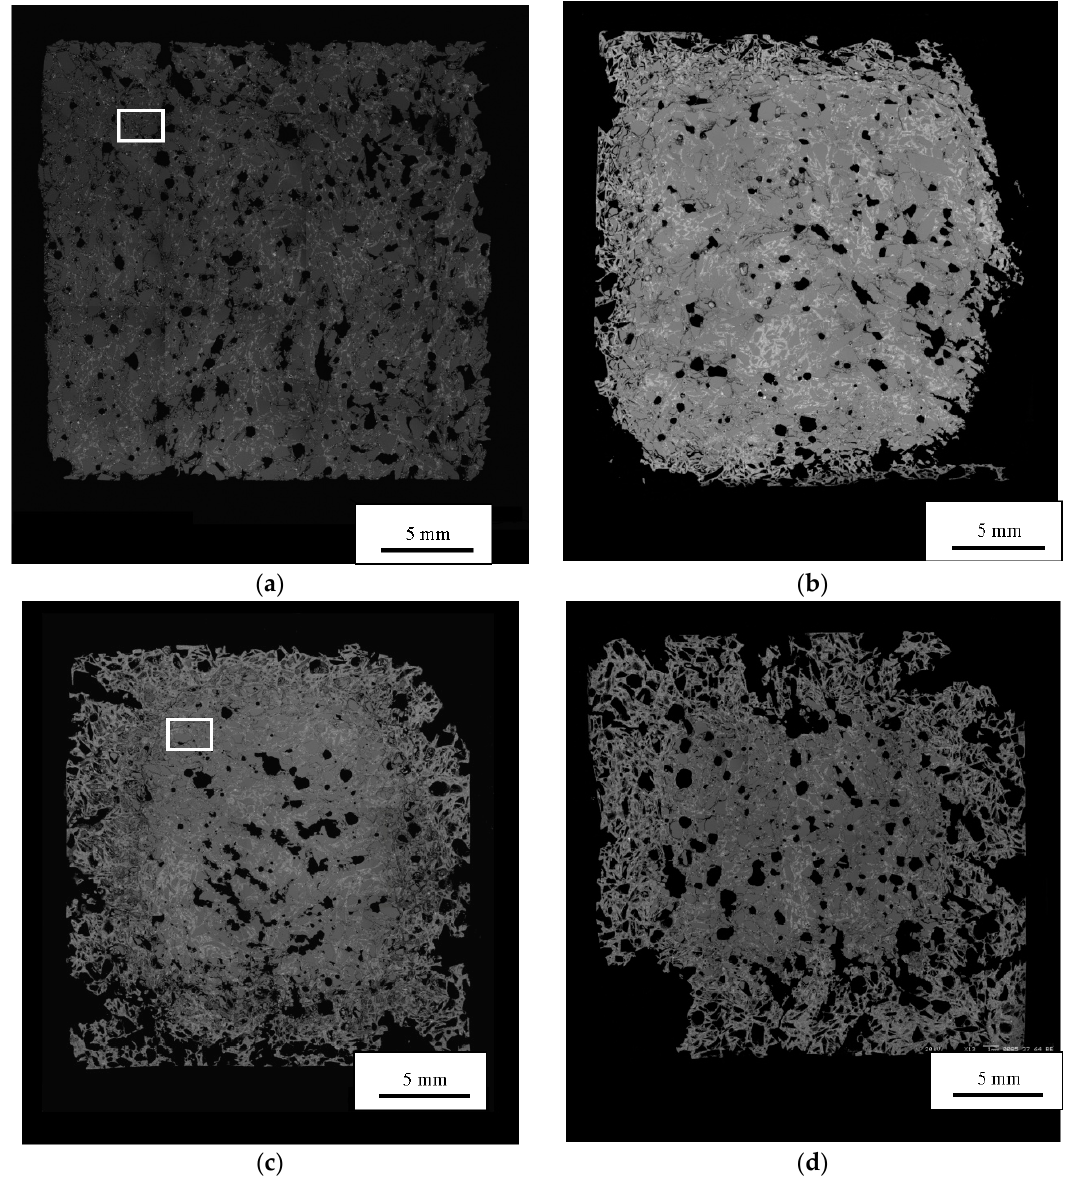
Figure 3. BSE images of entire cross sections of mortar bars at 0 ( a ); 3 ( b ); 21 ( c ); and 42 ( d ) days.